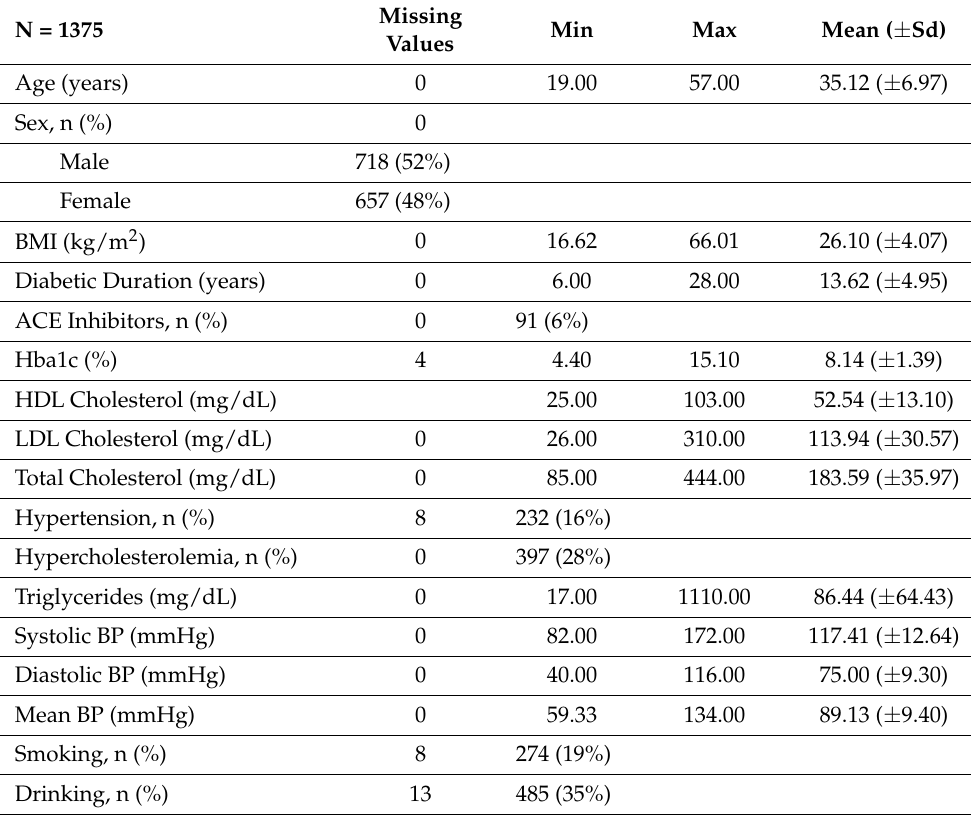
Table 1. Baseline Characteristics of the EDIC Patients.